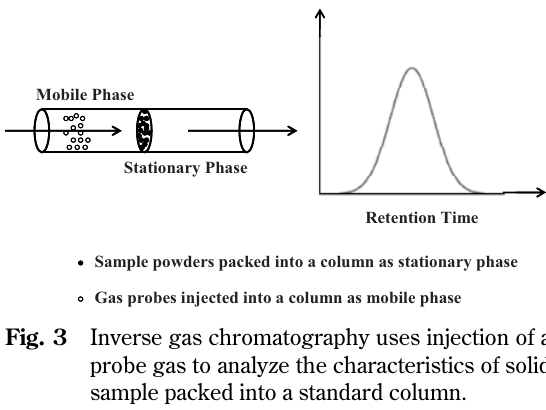
Fig. 3 Inverse gas chromatography uses injection of a probe gas to analyze the characteristics of solid sample packed into a standard